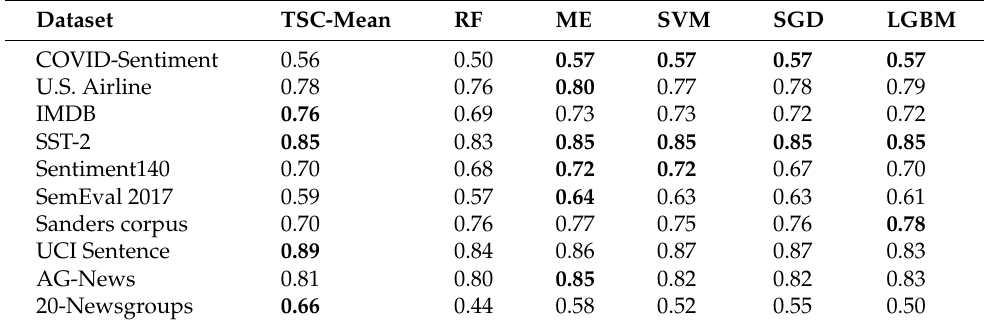
Table 8. SBERT vector-based Weighted Recall score for six classifiers. Best results are in bold face. Dataset